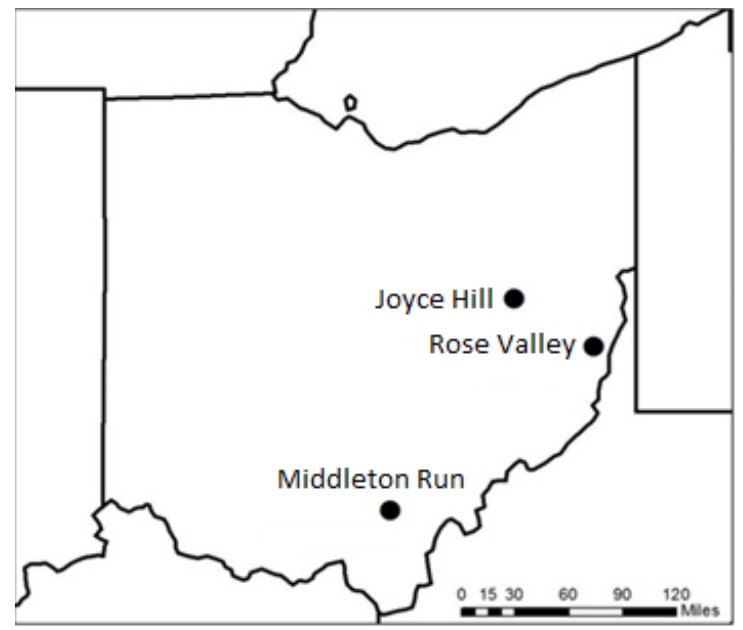
Figure 1. Map of site locations.